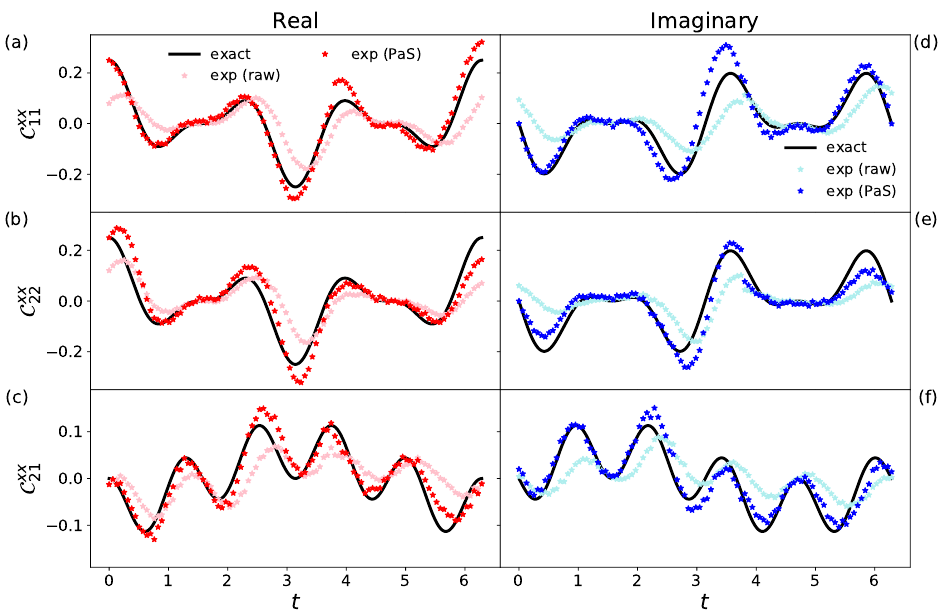
Figure 5. Real ( a – c ) and Imaginary ( d – f ) parts of the dynamical correlation functions C xx i = j = 1,2 ( top panels) and i = 2, j = 1 ( bottom ) on a N = 4 closed Heisenberg ring, in the large-field region. Phase and scale correction, as in Ref. [89], has been applied to the raw results computed on the ibmq_bogota IBM Quantum processor, obtaining a very good agreement with exact